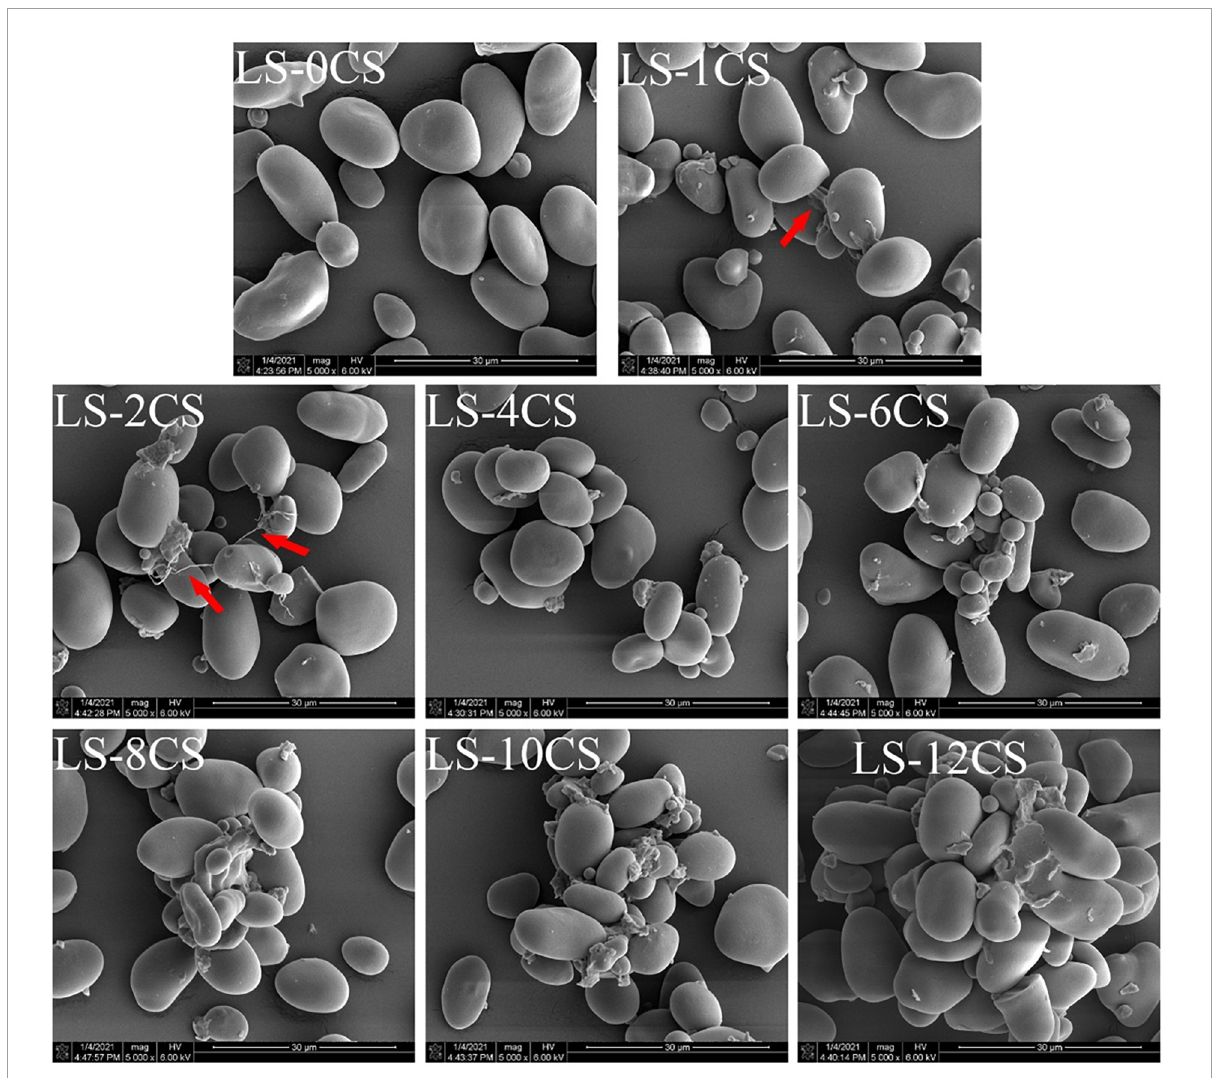
FIGURE3 Scanning electron microscope images of lotus seed cross-linked resistant starch